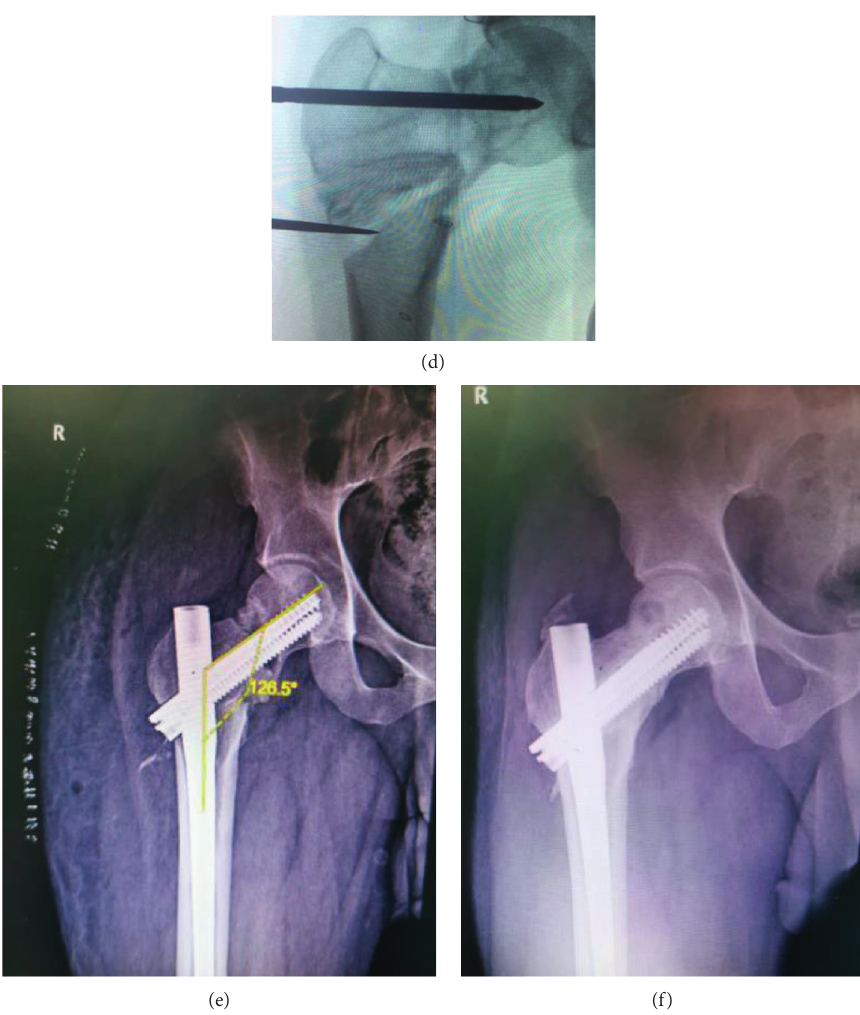
Figure 1: An AP radiograph of the pelvis and right hip reveals a nonunion neck of femur fracture with varus deformity, assessed at 81 degrees Pauwels angle. Hardware that has been bent. (b) Intraoperative image shows pseudoarthrosis with lysis and scelorosis, as well as impending hardware failure. (c) Visualization of Pauwels’ osteotomy execution during surgery. (d) The wedge bone was leveraged into the bone defect by 7 mm cannulated screws that were removed. (e)-(f) Radiographs depicting the postoperative outcome and a 12-month follow-up.